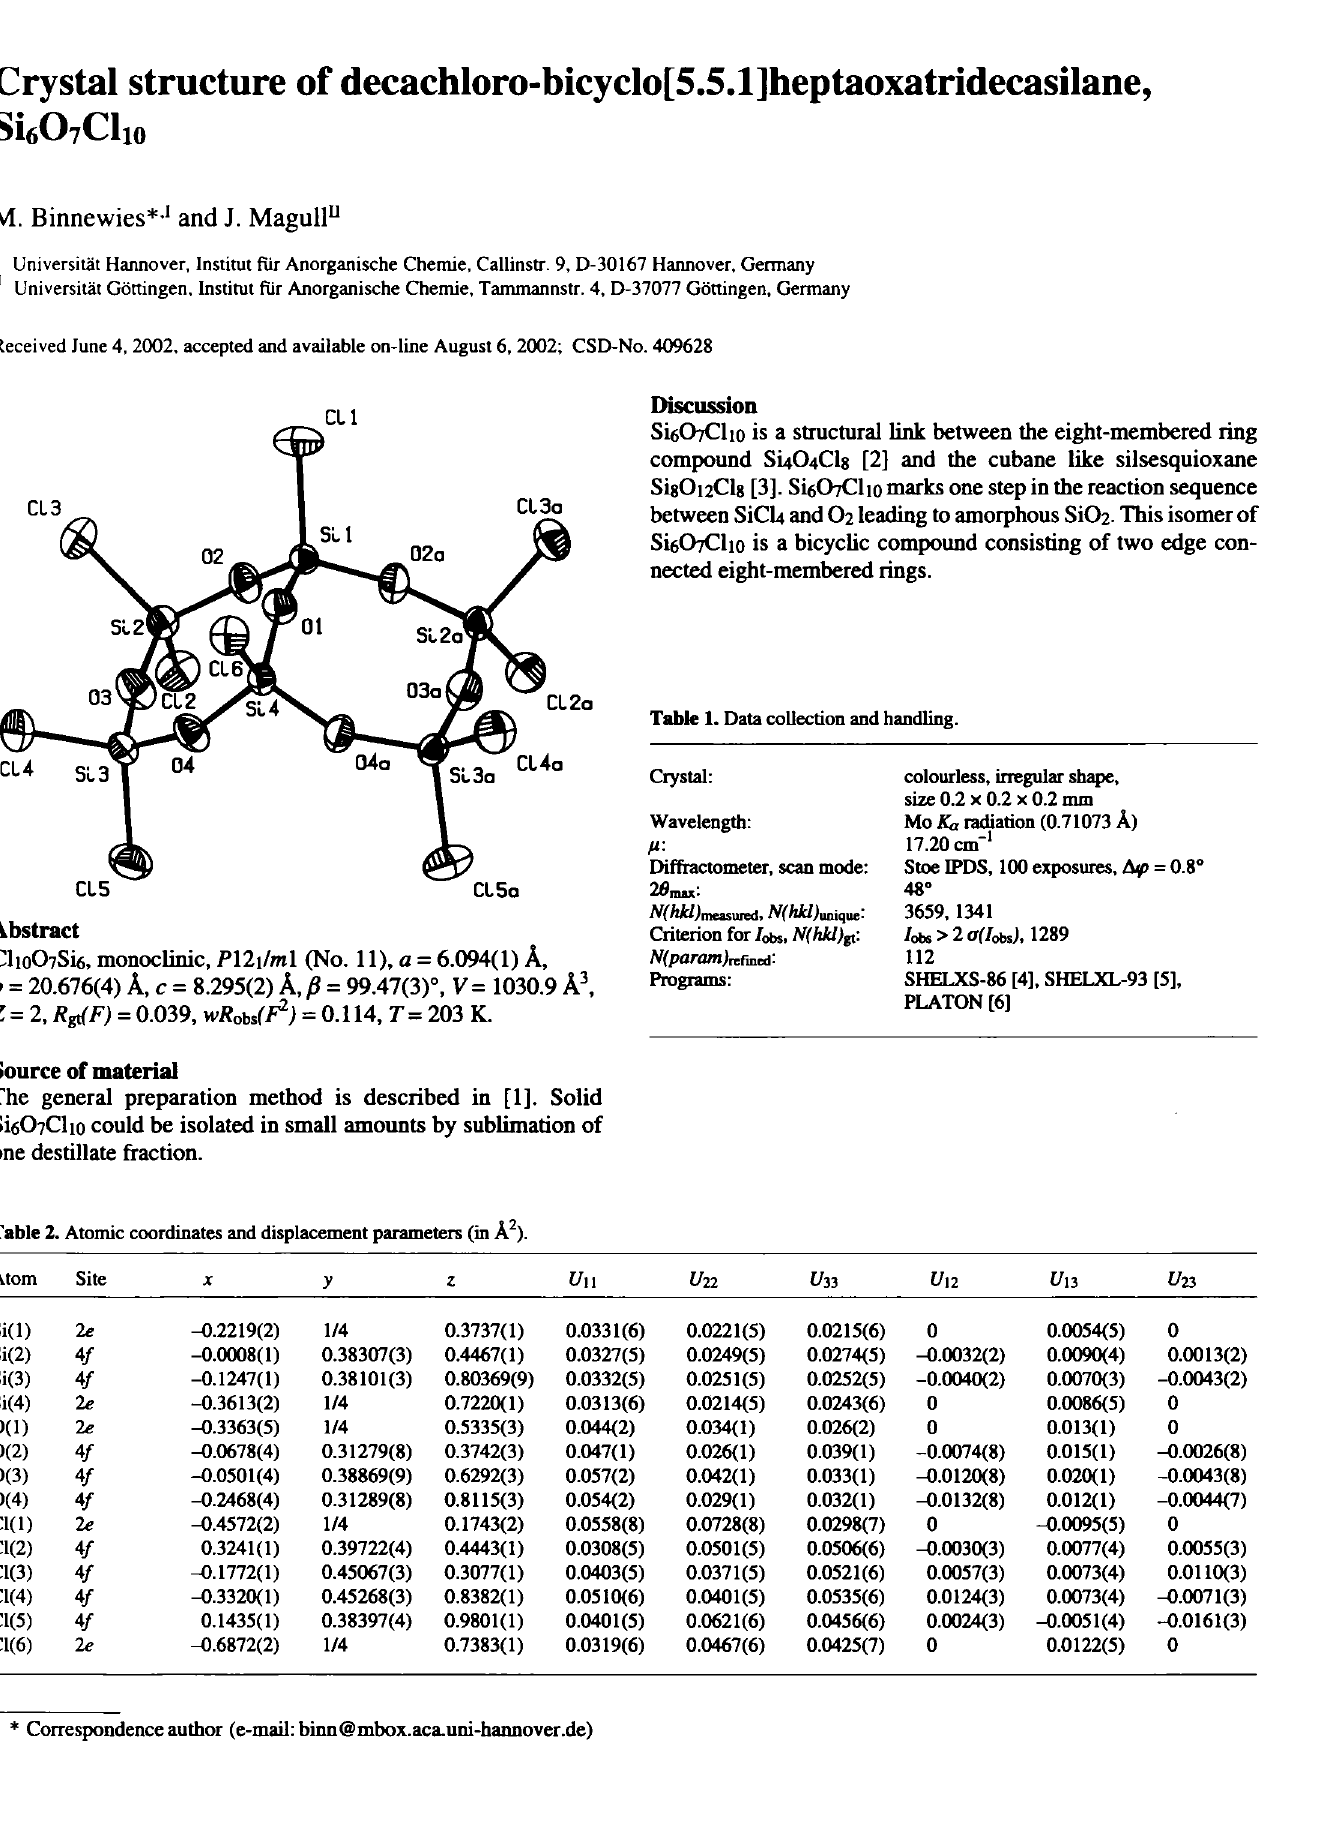
Table 1. Data collection and handling.